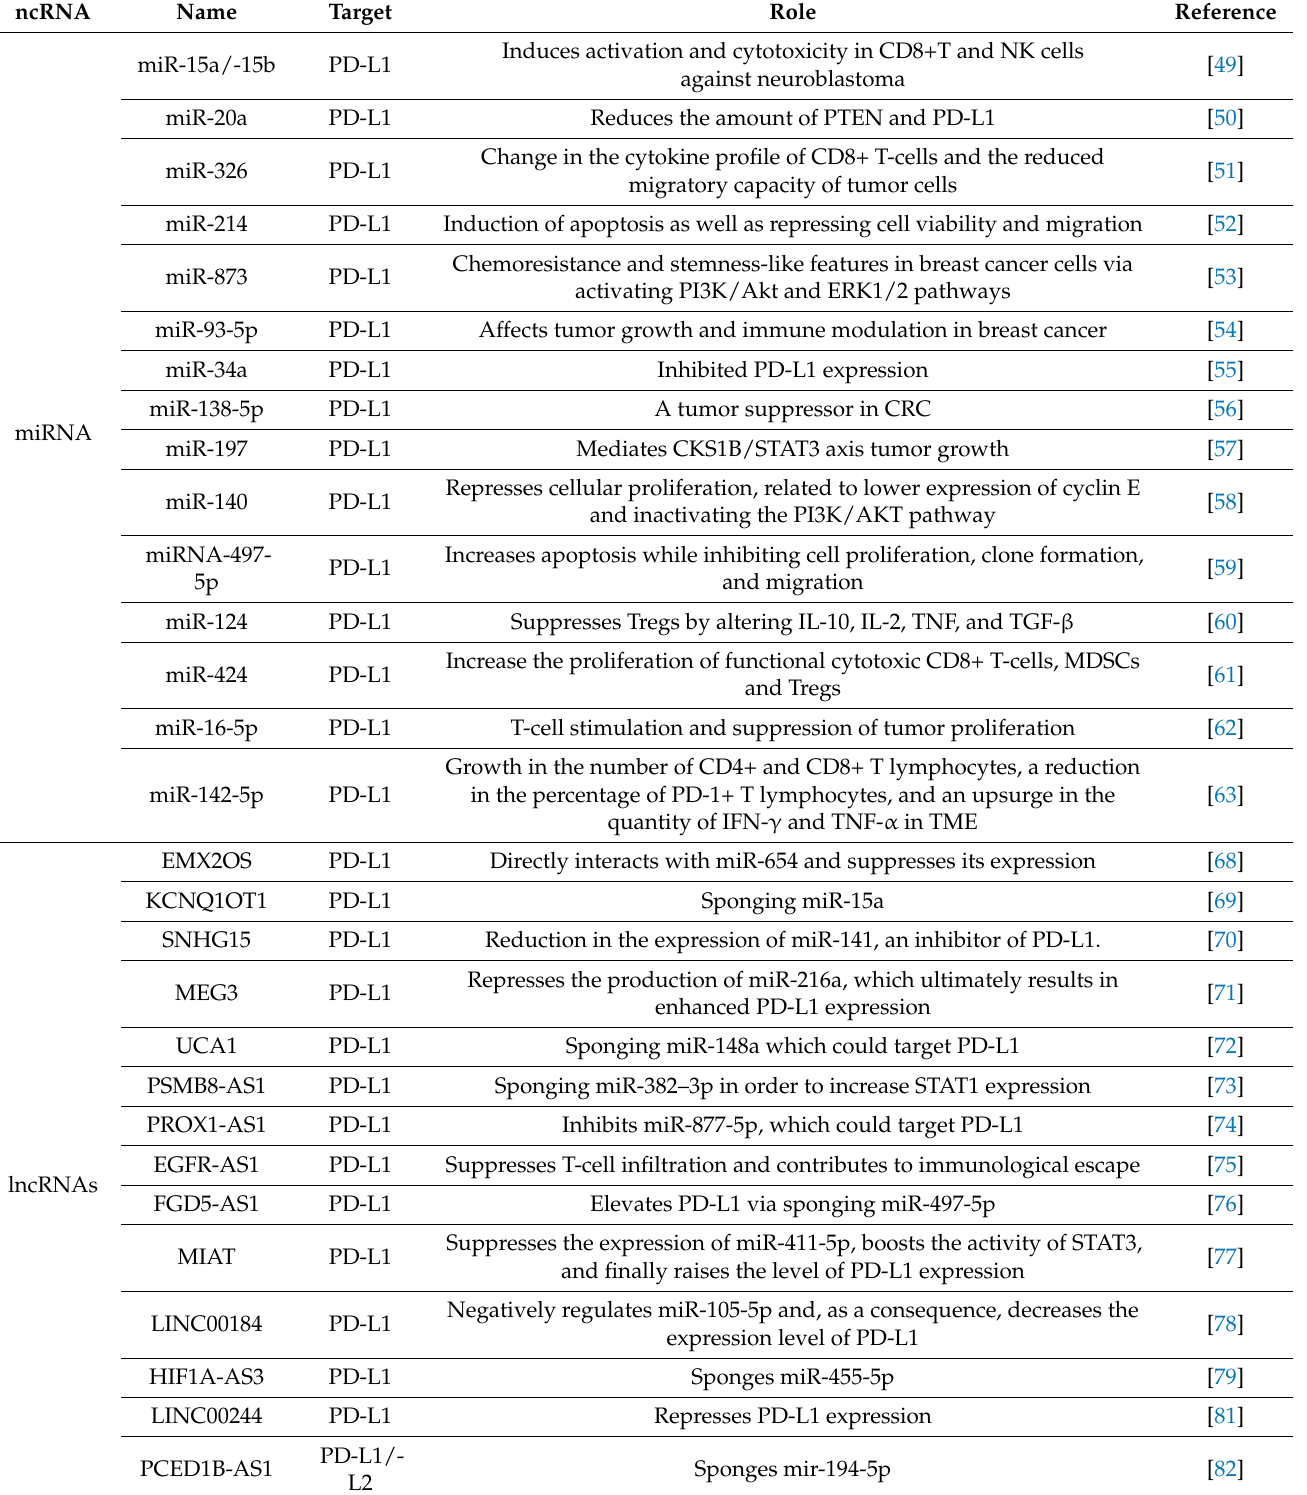
Table 1. ncRNAs and their mechanisms to regulate